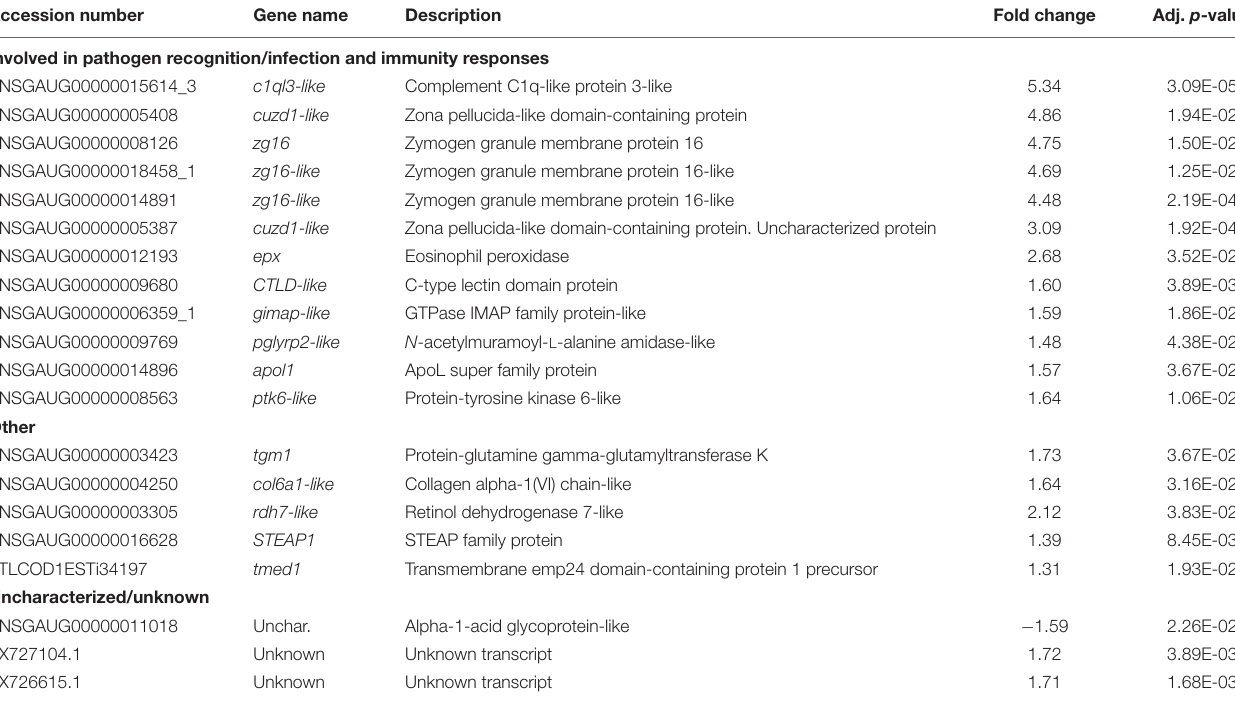
TABLE 2 | Summary of the significantly ( p < 0.05) up and down regulated transcripts in cod larvae from the FTS compared to larvae from the the RAS on 17 dph.